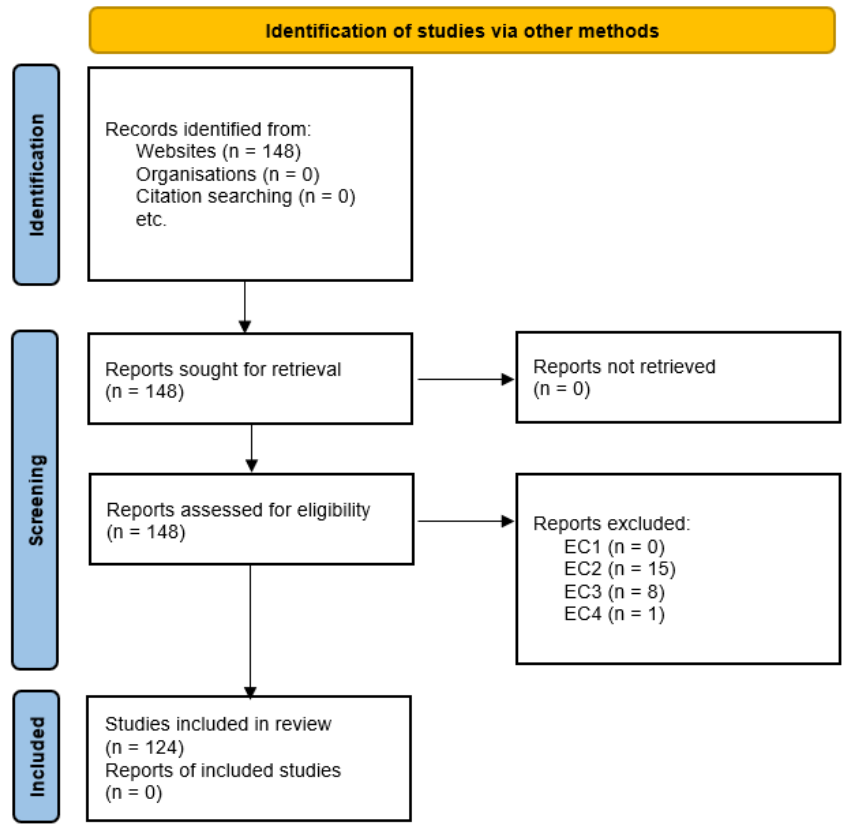
Figure 1. PRISMA flow diagram followed in the analysis. As no databases were consulted in the search, those flowchart boxes do not